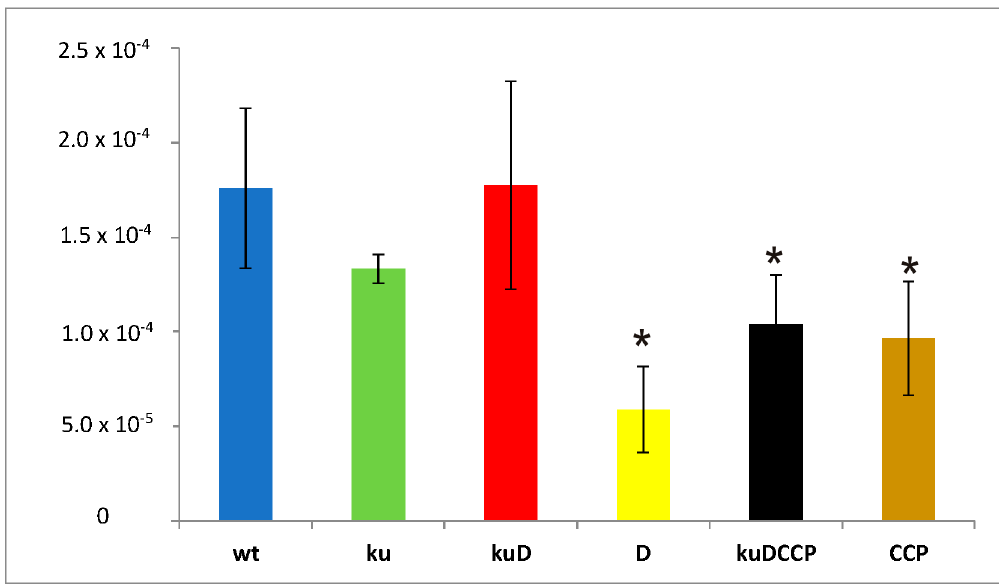
Figure 2. Number of sucrose-resistant mutants identified in wild-type M. smegmatis (wt) and all analyzed mutants (ku- ∆ ku, kuD- ∆ ku-ligD, D- ∆ ligD, kuDCCP- ∆ ku-ligD-ligC 1 -ligC 2 -primC, and CCP- ∆ ligC 1 -ligC 2 -primC ). The number of viable cells was calculated based on CFU enumerations from three independent experiments and plotted as the average ± standard deviation. One-way analysis of variance (ANOVA) (Holm–Sidak method) was employed for multiple comparisons versus the control samples (mc) to determine any significant differences between the mean values of the wild-type and mutant strains. The results were considered to be statistically significant (*) at p <